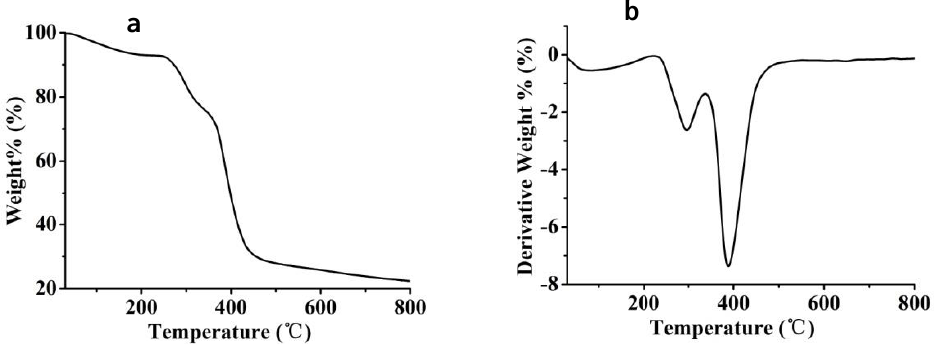
Figure 3. ( a ) TG and ( b ) DTG curves of cryogel F.